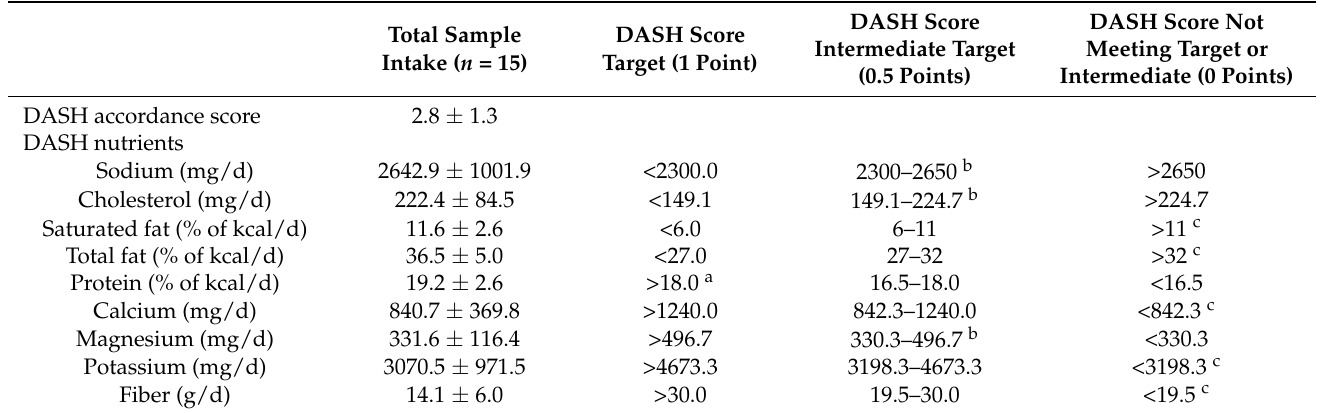
Table 3. DASH Diet Nutritional Intake (mean ± SD) and Nutrient